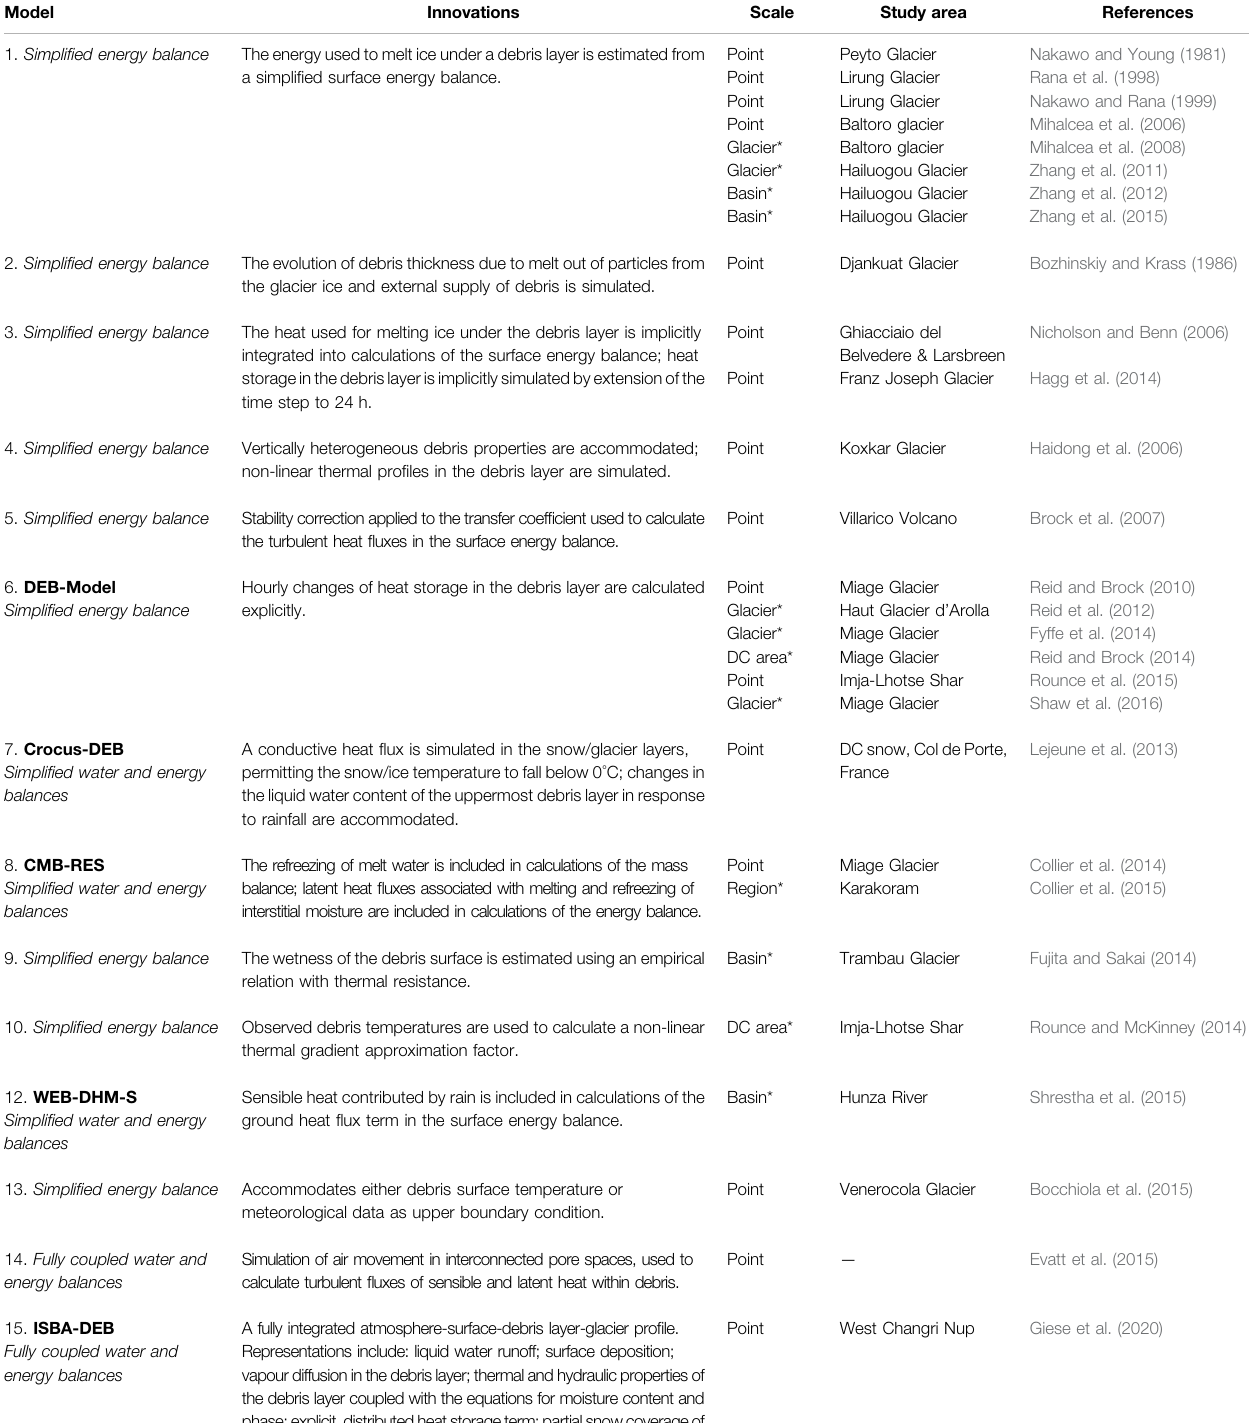
TABLE 1 | Physically based models that have been applied to predict ablation of glacier ice under a debris layer. At a minimum, the models listed compute vertical heat conduction through the debris layer. Additional processes involved in melting of glacier ice under a debris layer that are represented in each model have been summarised under the heading Innovations . Groups of models having the same physical representations are listed against a number from 1 to 15, in order of increasing physical completeness. In each of the 15 groups, studies in which the models were applied are listed chronologically by the date of publication. Some of the models were named by their authors, in which case their name is given in bold font under the heading Models .